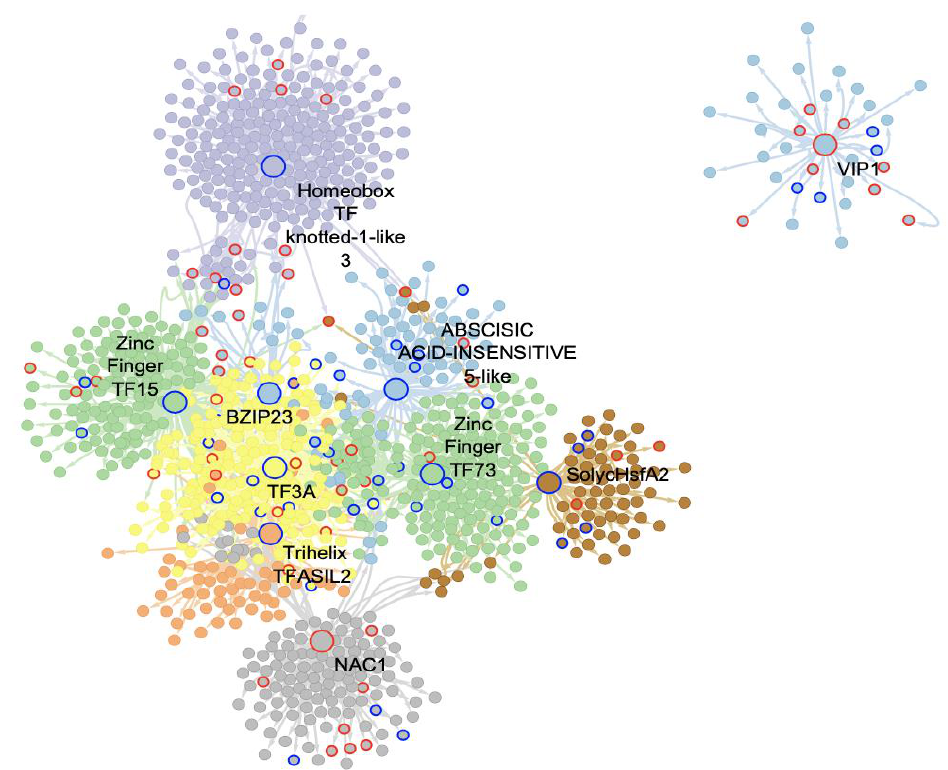
Figure 5. Interactome of the top unique MTRs in the severe comparison. Each node represents a gene, and the edges between nodes represent interactions between genes (regulation). Each MTR is represented by a large node, and the surrounding medium-sized nodes of the same color represent genes under its regulation (regulon). Each color represents a family: blue belongs to the bZIP family, while those green belong to the ZF-HD family. Genes in different colors are unique members of other families. The colored perimeters in blue indicate downregulation, while red depicts upregulation.